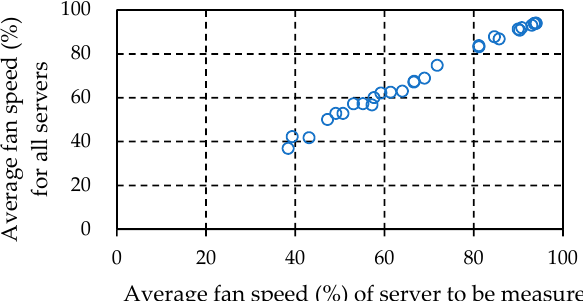
Figure 7. Comparison of average fan speeds of server to be measured and all servers (experiments A and B).